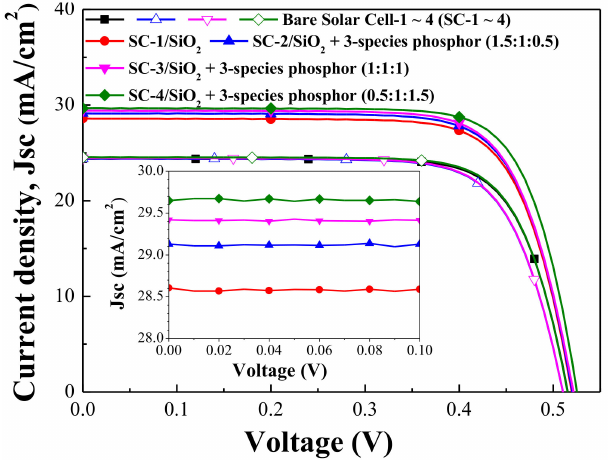
Figure 7. Photovoltaic J–V curves of bare silicon solar cell, cell coated with 250-nm thick layer of pure SiO 2 , and cells coated with SiO 2 layer that includes three species of Eu-doped phosphor at various